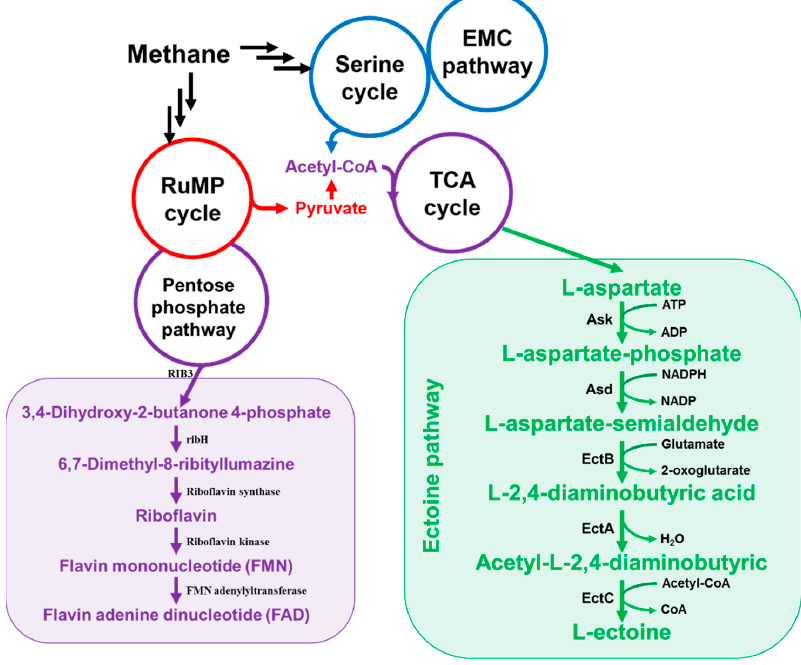
Figure 3. Biosynthetic pathway of riboflavin and ectoine in methanotrophs.